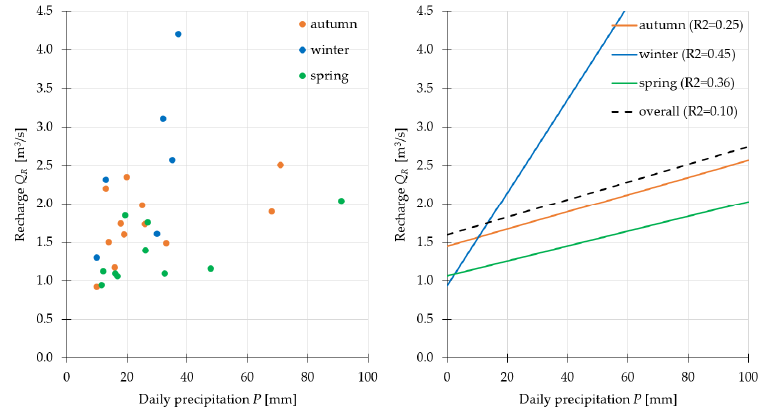
Figure 8. Scatterplot of recharge against daily rainfall for p > 10 mm/day.